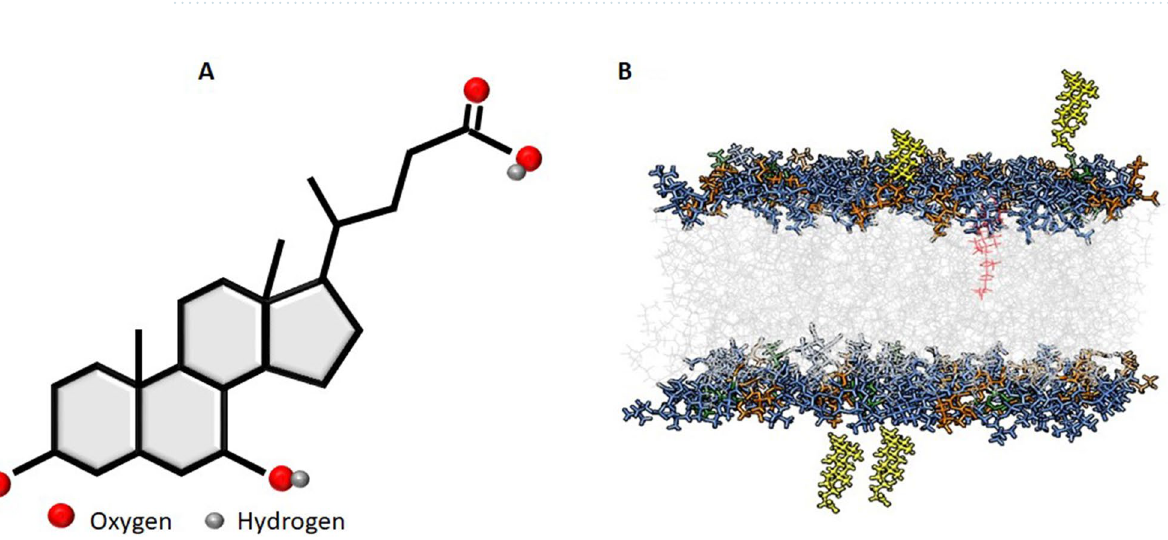
Figure 1. UDCA structure and identification and distribution of UDCA in the different membranes. ( A ) UDCA schematic representation, using the SMILE code (CC(CCC(= O)O) C1CCC2C1(CCC3C2C(CC4C3(CCC(C4)O)C)O)C). ( B ) Membrane ERGIC-like. All membranes (VIR, ERGIC, and PLASM) had a similar UDCA spatial distribution. This figure shows an ERGIC-like